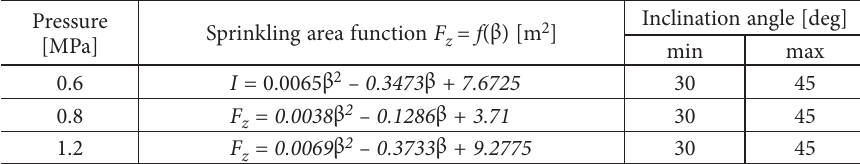
Table 1. A set of sprinkling area function F z = f (β) for solid jet obtained as a result of approximation procedure